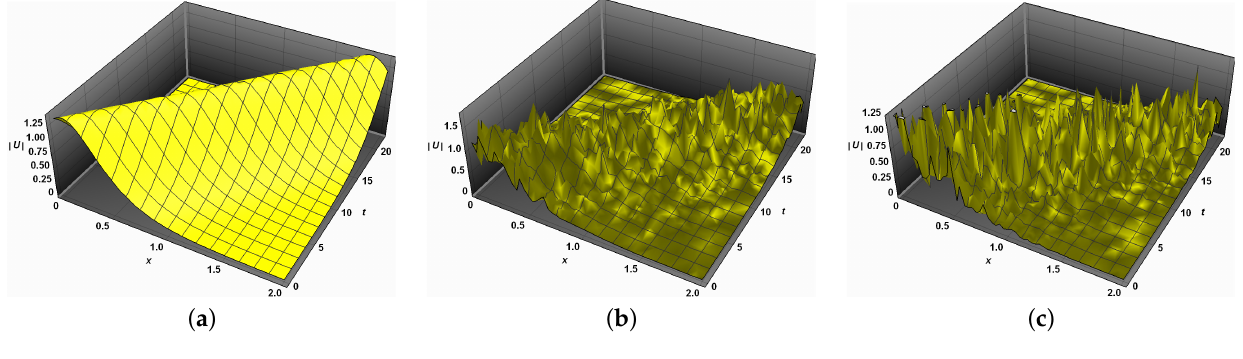
Figure 7. The solution (38) for different values of the noise σ and α = 1, y = 0.5 and ( x , t ) ∈ [ 0,2.5 ] × [ 0,22 ] . ( a ) σ = 0.0; ( b ) σ = 0.2; ( c ) σ = 0.5.